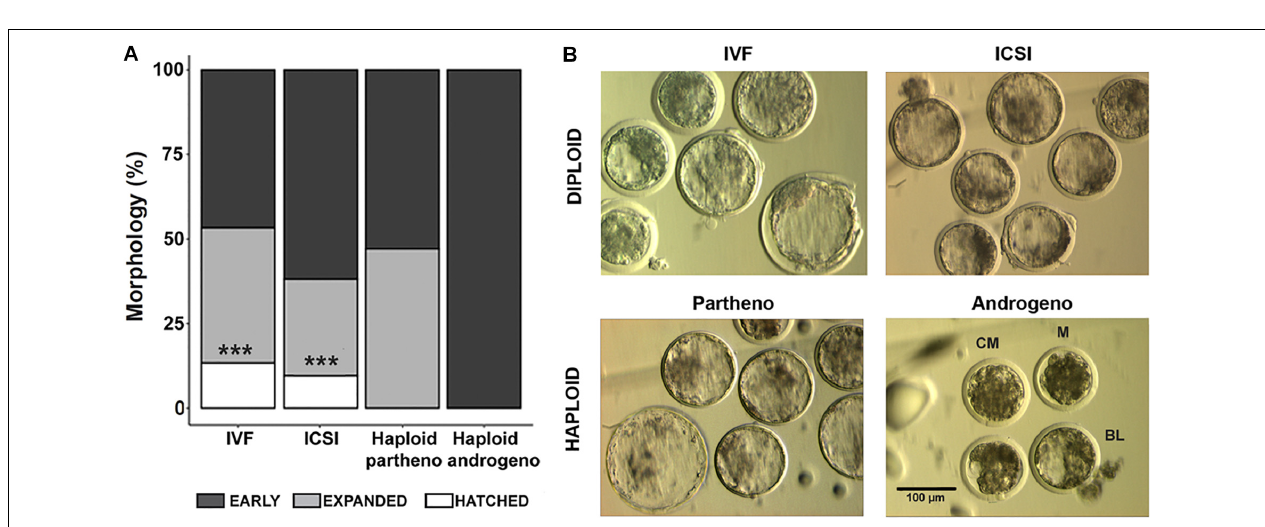
FIGURE 2 | Development to cleavage (Day-2) and blastocyst (Day-7) stages of embryos produced by in vitro fertilization (IVF), intracytoplasmic sperm injection (ICSI) using non-sexed and sexed sperm, haploid parthenogenetic and androgenesis using sexed spermatozoa. IVF, in vitro fertilization. ICSI (female): intracytoplasmic sperm injection using Y-chromosome sorted sperm. ICSI (male), intracytoplasmic sperm injection using X-chromosome sorted sperm. Haploid partheno, haploid parthenogenetic embryo obtained by oocyte activation using ionomycin followed by cyclohexymide. Haploid androgeno-X, haploid androgenetic embryos generated using X-chromosome sorted sperm. Haploid andro-Y, haploid androgenetic embryos generated using Y-chromosome sorted sperm. n.a. data is not available. Asterisks denote significant differences within columns ( ∗ p < 0.05, ∗∗ p < 0.01, ∗∗∗∗ p < 0.0001).